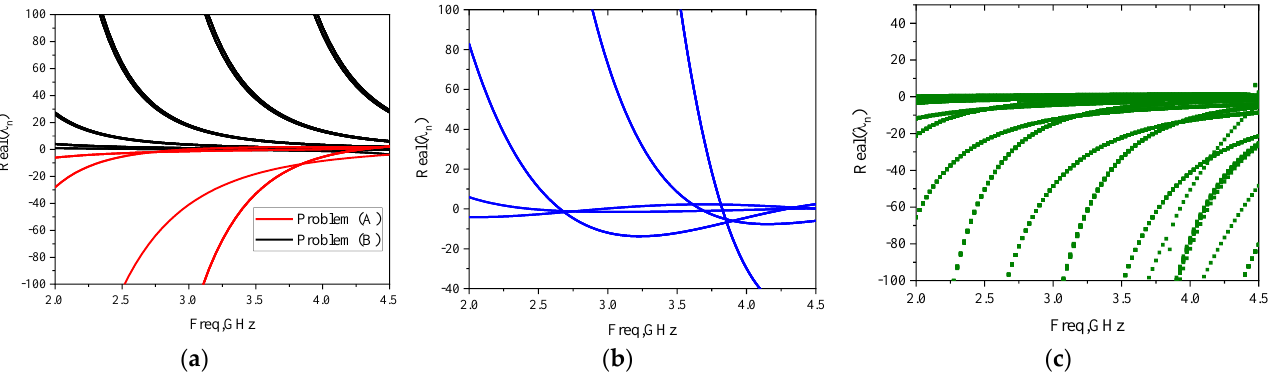
Figure 12. The real parts of characteristic eigenvalues of the first 150 lower-order modes in the frequency range from 2.0 GHz to 4.5 GHz for the four different problems. ( a ) Problems (A) and (B); ( b ) problem (C); ( c ) problem (D).